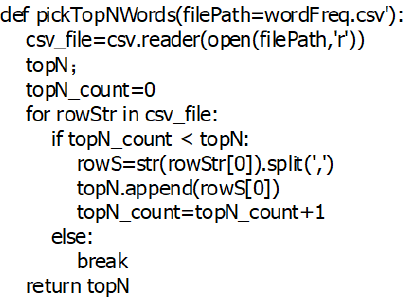
Figure A2. Pseudocode of counting word frequency.